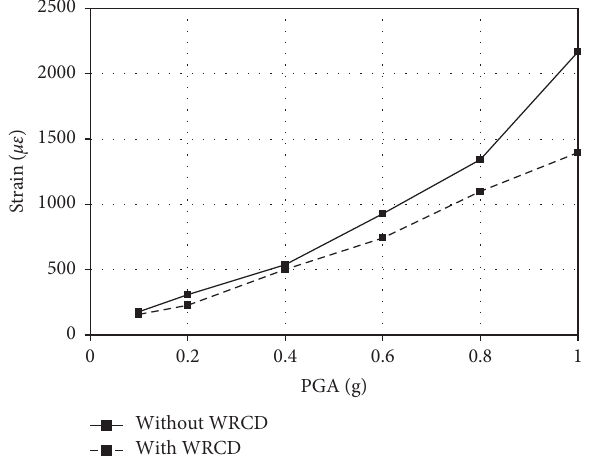
Figure 17: Maximum strain response at 2# fxed pier